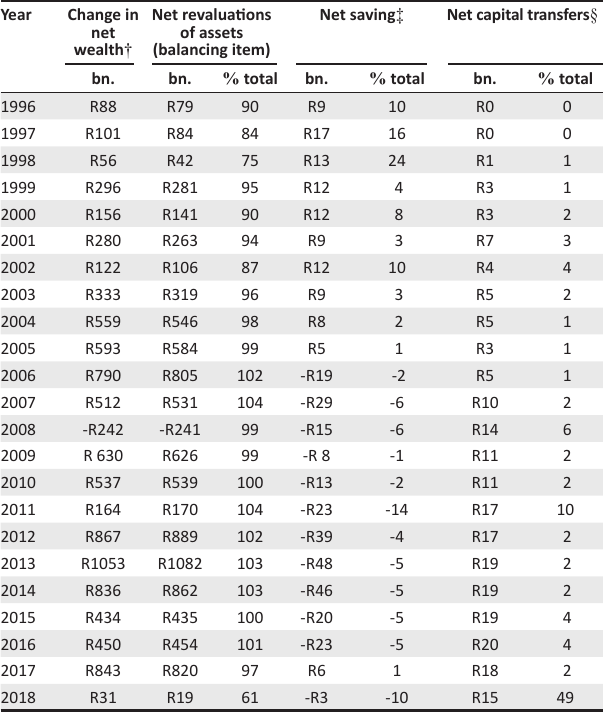
TABLE 3: Decomposition of households’ net wealth, 1996 to